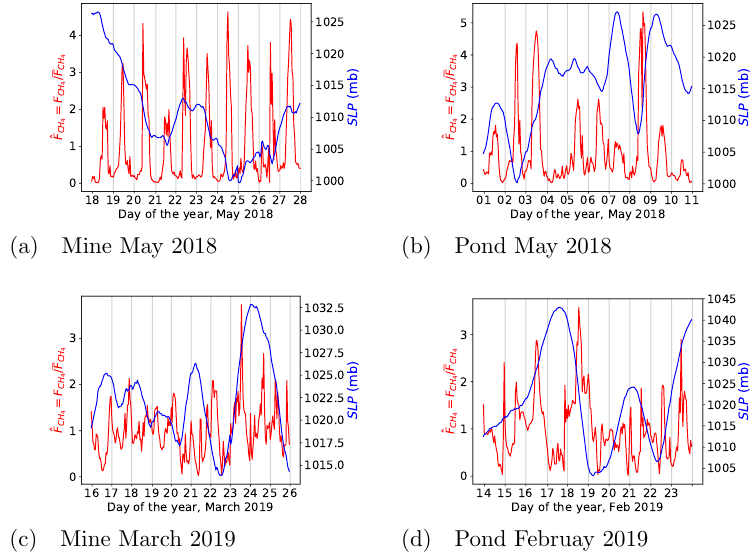
Figure A3. Time series of simulated normalized advective flux of methane ( ˆ F CH Pressure ( SLP ); numbers on the horizontal axis indicate the start of day using local standard time (LST = UTC − 7); ( a ) Mine May 2018; ( b ) Pond May 2018; ( c ) Mine March 2019; ( d ) Pond February 2019.